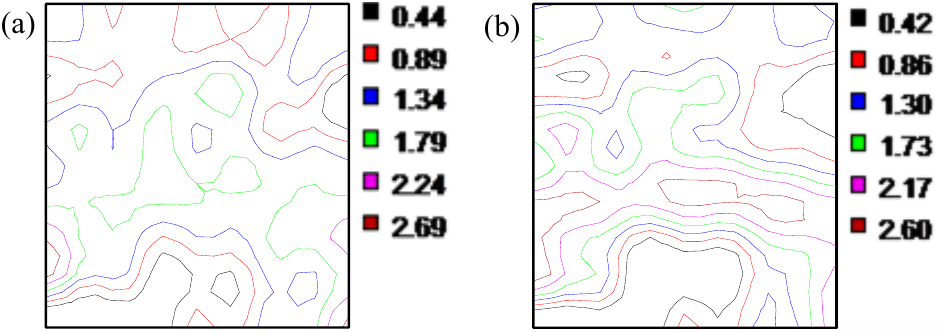
Figure 7. ODF cross sections of ϕ 2 = 45 ◦ of two groups of experimental steels under different heat treatment processes: ( a ) 0 RE, ( b ) 9 ppm RE. Table 3. Texture contents of each orientation after the ART annealing process.